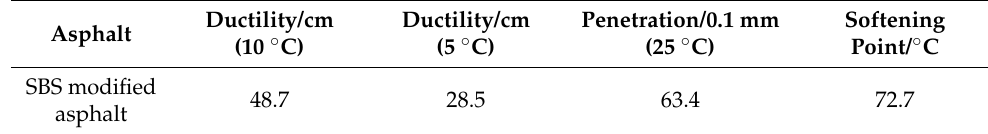
Figure 2. Schematic of each structure. Table 2. Basic performance data of asphalt.